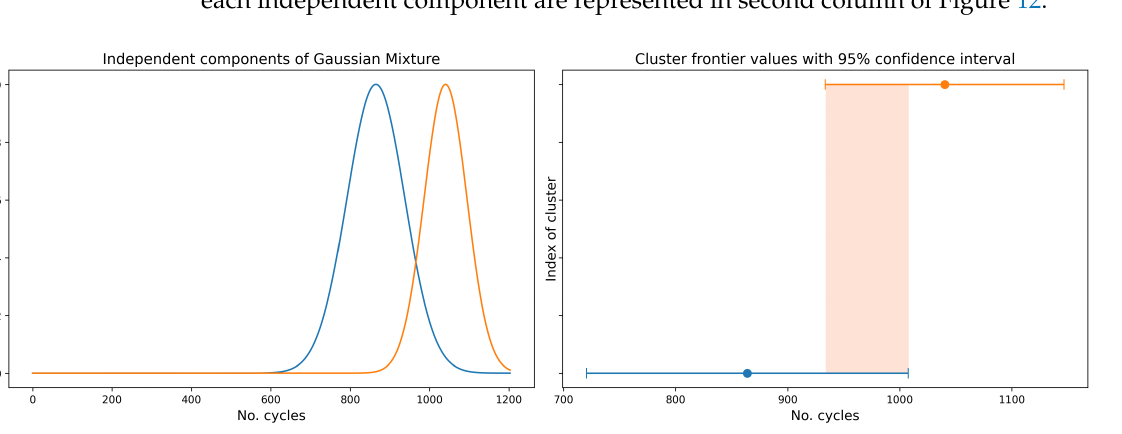
Figure 12. Cluster frontiers with 95% confidence